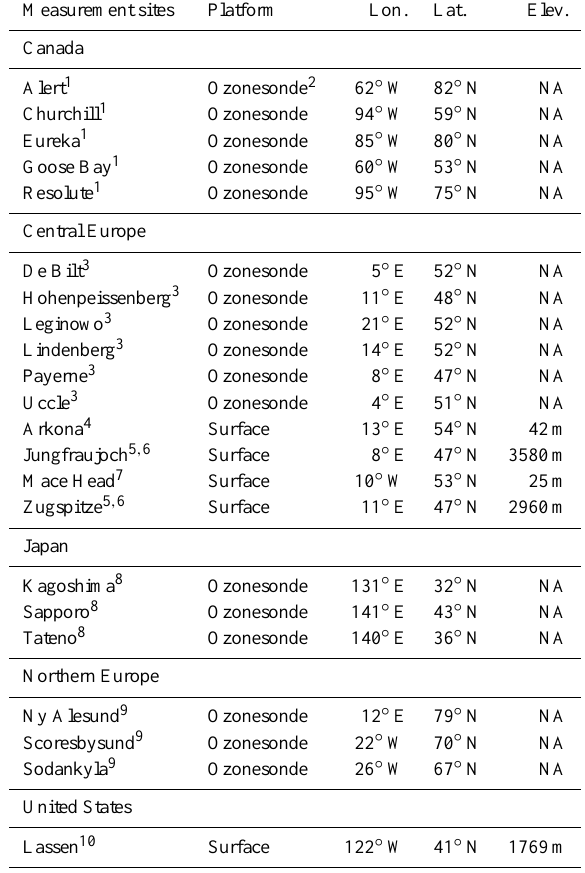
Table 1. Measurement sites used in this paper. Measurement sites